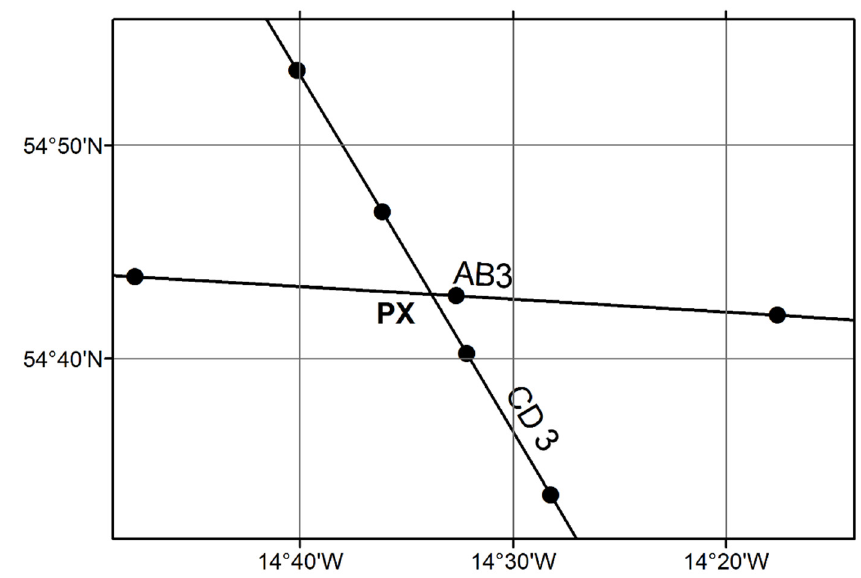
Figure 2. Intersection by densification of the geodesics in ArcGIS.